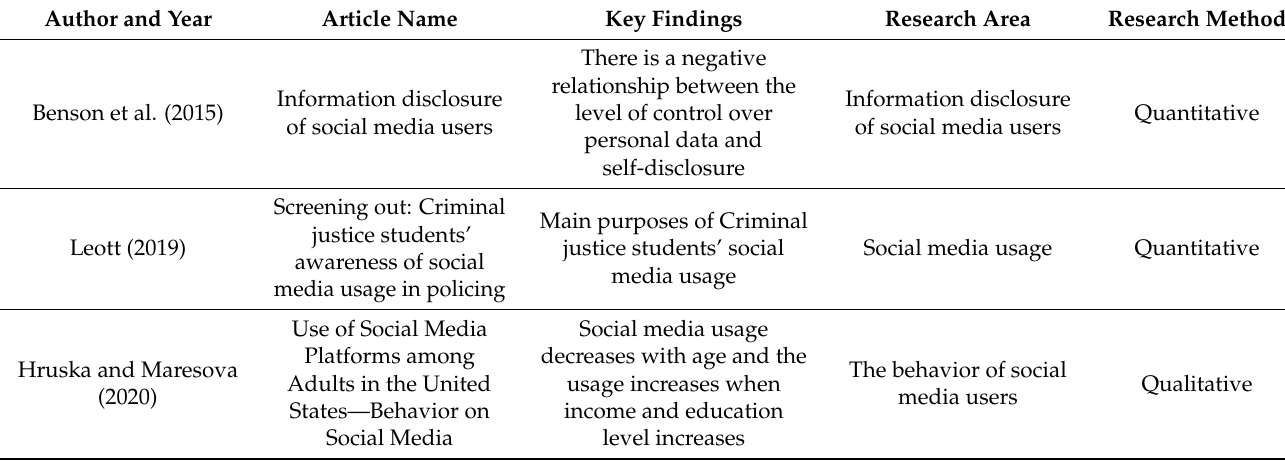
Table A8. User behavior when using social